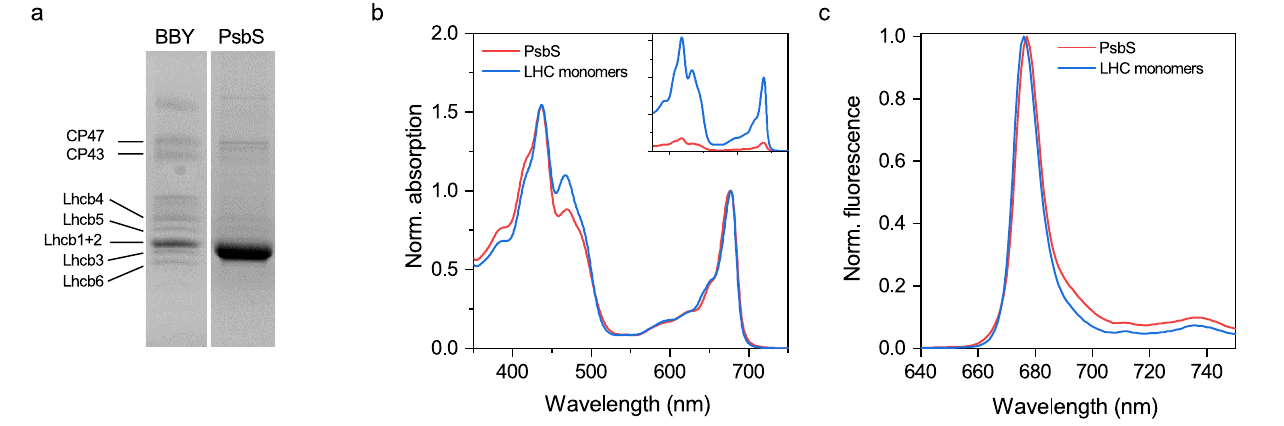
Figure 1. Protein composition and spectral characteristics of the PsbS eluate following strep-tactin affinity chromatography. ( a ) SDS-PAGE of WT BBY membranes and PsbS eluate. Lanes are cropped from different parts of the same gel. The uncropped gel is presented in Supplementary Figure S4. ( b ) absorption spectra of PsbS eluate and LHC monomers normalized to the Q y maximum. The inset shows the absorption spectra normalized to protein concentration. ( c ) 77 k fluorescence emission spectra of PsbS eluate and LHC monomers normalized to the maximum. Results are representative of three independent experiments with similar